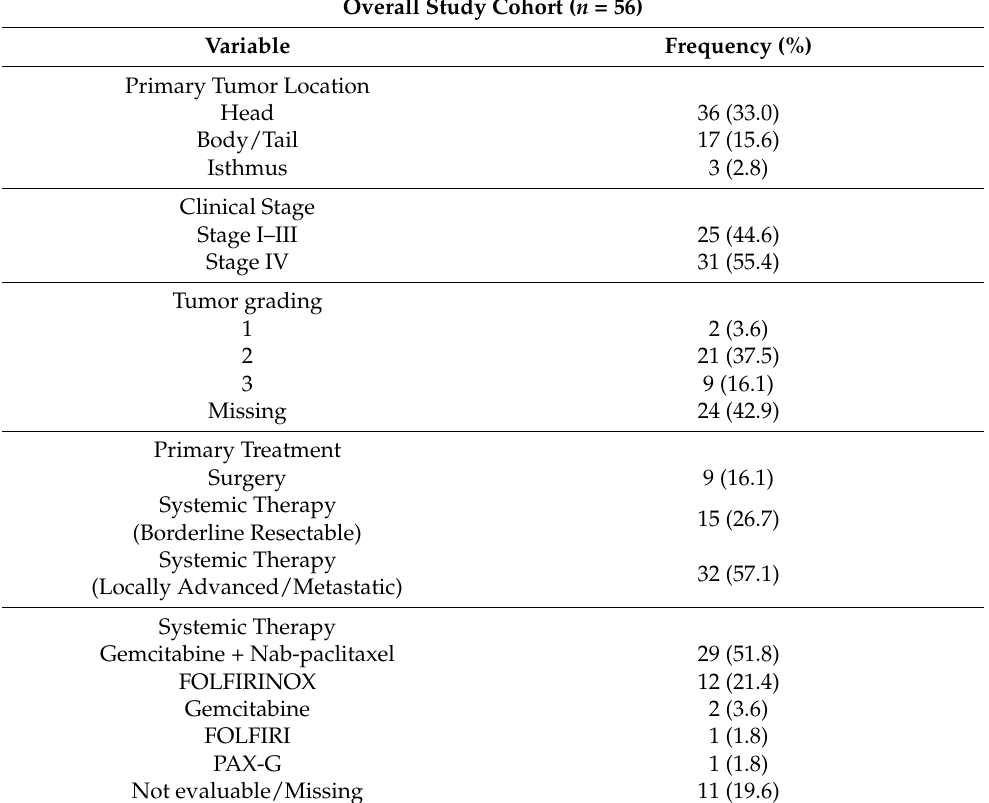
Table 1. Characteristics of the overall patient cohort ( n = 56).